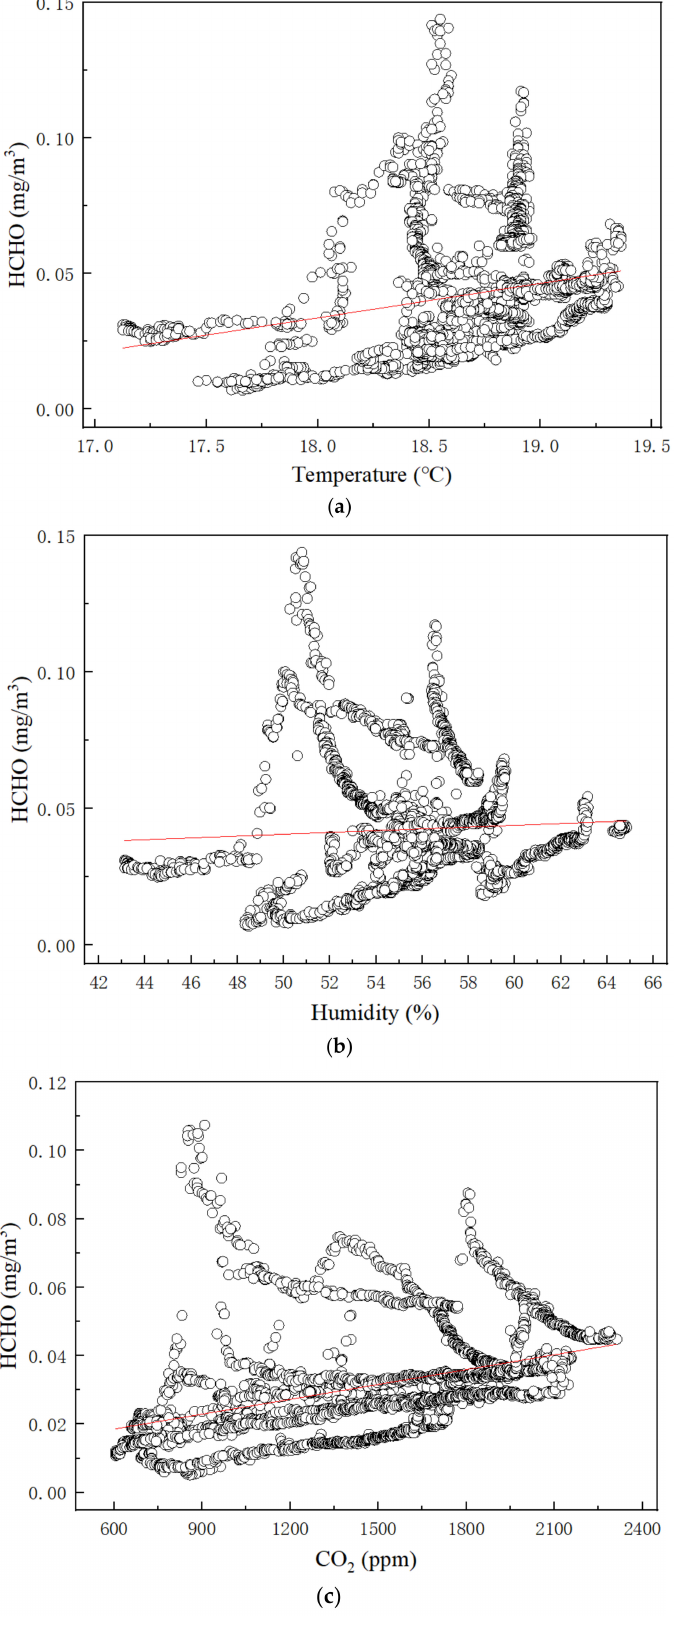
Figure 15. Correlation between HCHO and other parameters. ( a ) Correlation between HCHO and temperature. ( b ) Correlation between HCHO and humidity. ( c ) Correlation between HCHO and CO 2